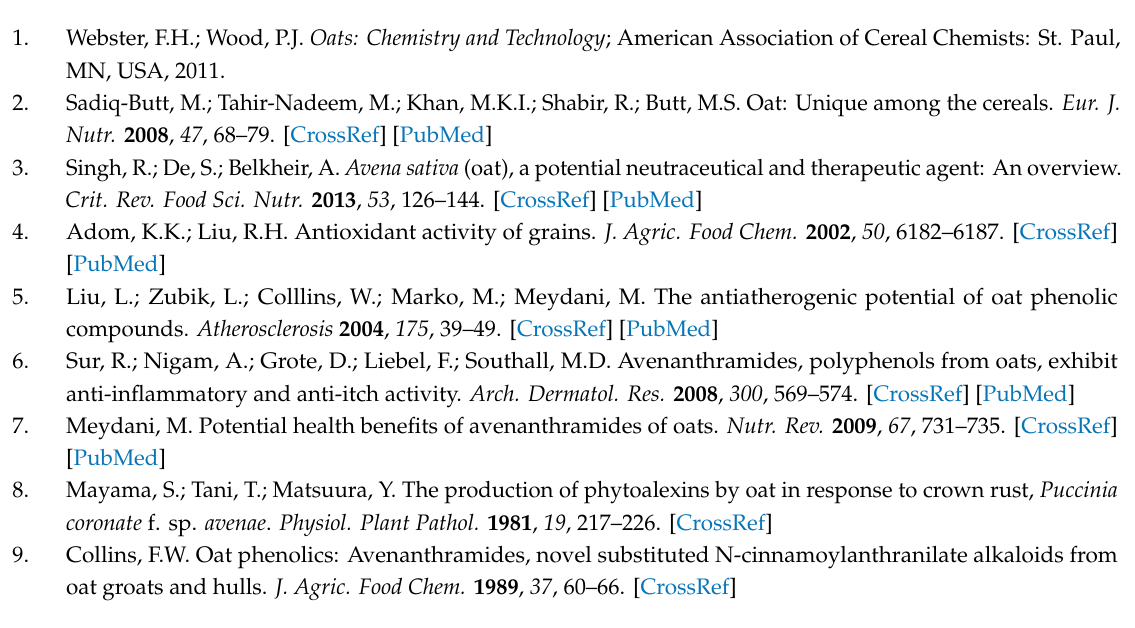
Figure S1. Sequence alignment for two 4CLs from oat with the coding region sequence (CDS) ( A ) and amino acids ( B ). The shaded regions indicate amino acids that are identical to each other. The two conserved domains for 4CL enzymes were shown in red box; Figure S2. The negative controls with boiled As4CL1 enzymes were shown with corresponding subtracts. Figure S3. Full sequences alignment of oat HHTs. Shaded regions indicate amino acids that are identical to each other. Black double-headed arrows indicate the conserved domain HXXXDG and motif DFGWG in BAHD acyltransferases; Figure S4. Representative images for the MS spectra of group fragments from the products Avn-A ( A ) and Avn-C ( B ). Putative dissociation mechanisms for these compounds were shown; Figure S5. Kinetic analysis of oat CCoAOMT enzyme. The kinetic constants were estimated from Michaelis-Menten plot using the average of three biological triplicate measurements; Figure S6. Representative image showing purified CCoAOMT proteins separated by 12% SDS-PAGE. M: prestained protein marker; A209D: CCoAOMT A209D ; K174A: CCoAOMT K174A ; D246A: CCoAOMT D246A ; Nucleotide sequence data reported